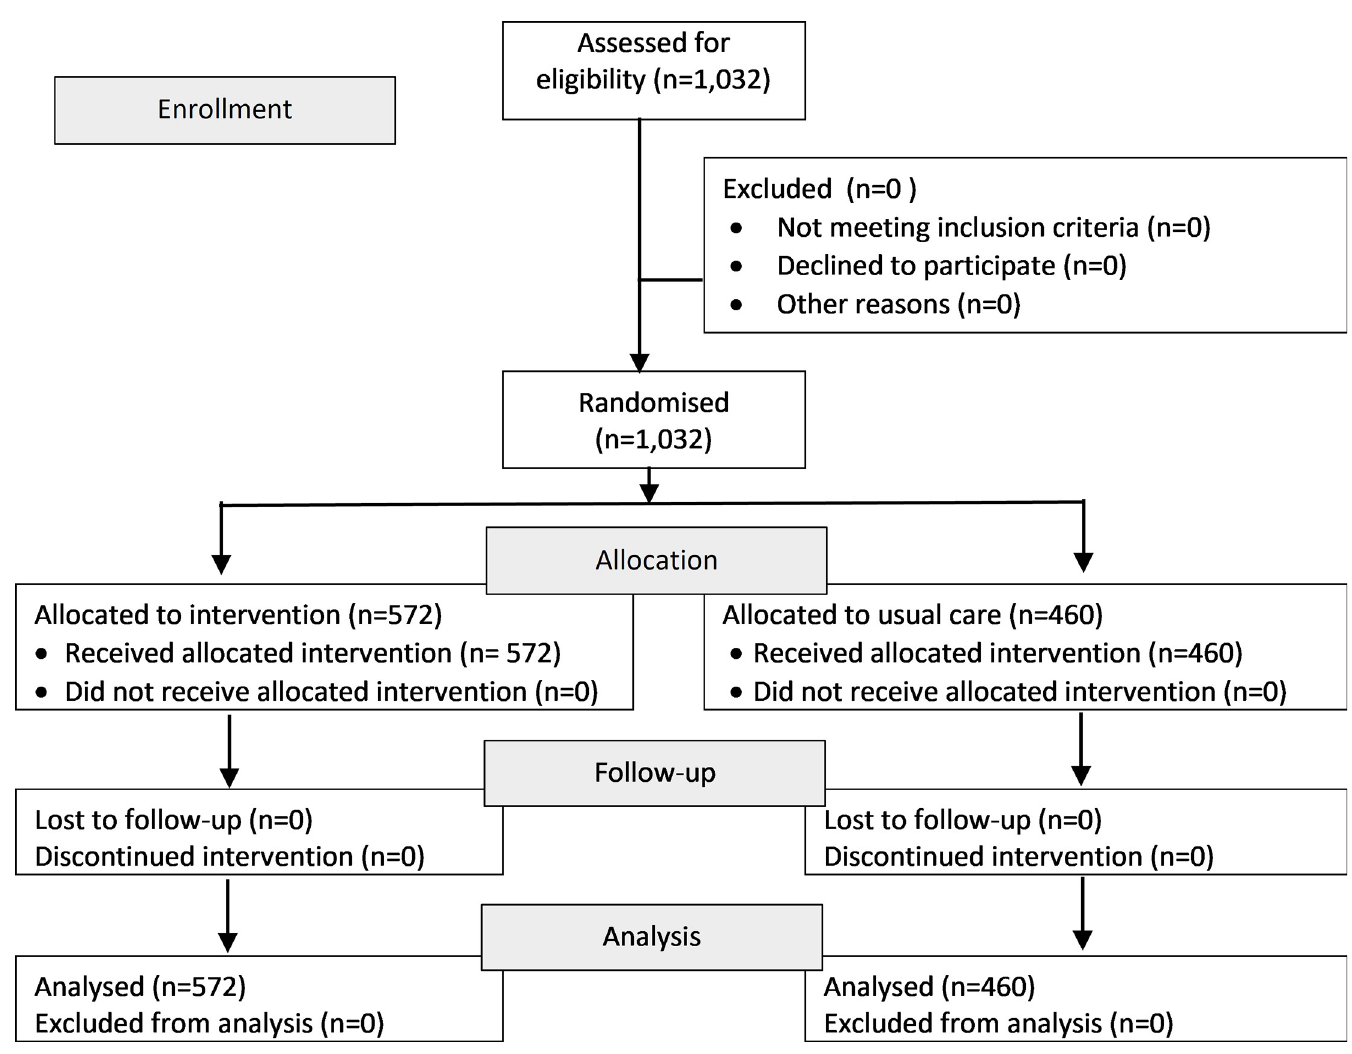
Fig 1. CONSORT flow diagram for letters trial